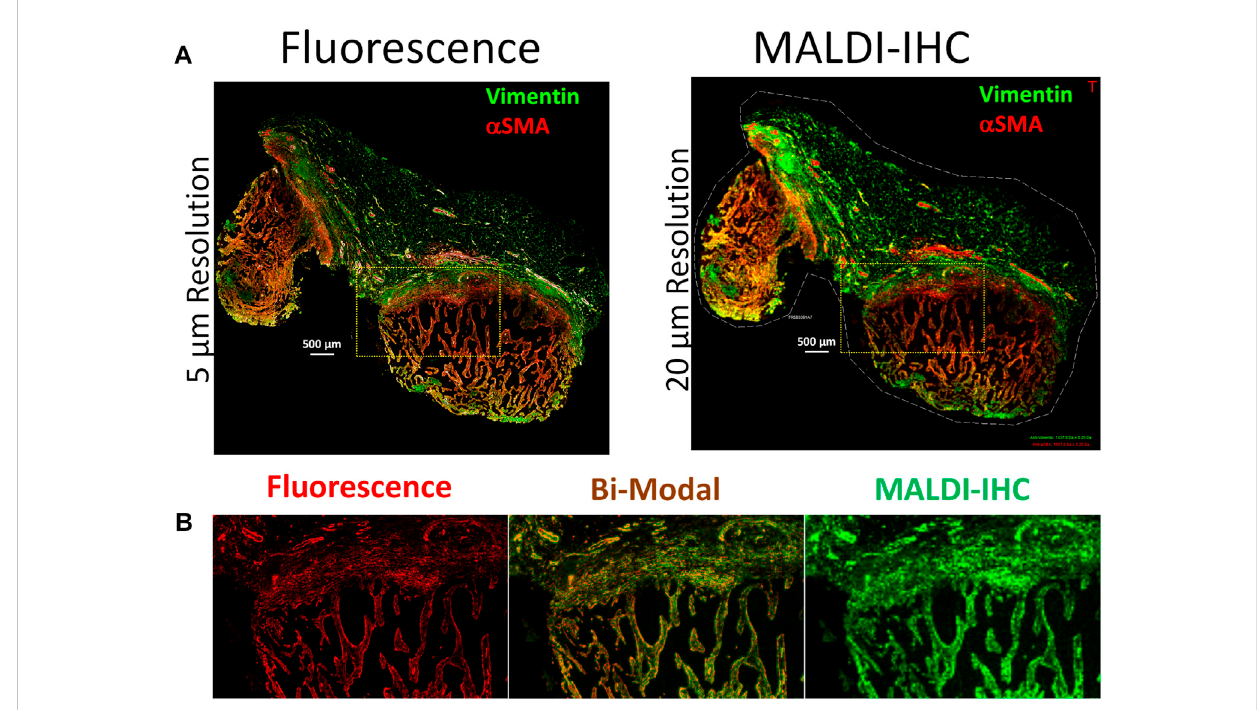
FIGURE 2 Multimodal imaging of an FFPE breast cancer tissue using dual-labeled Miralys ™ probes. (A) Comparison of fl uorescence (left) and MALDI-IHC (right) images for the dual-labeled vimentin and alpha smooth muscle actin ( α SMA) probes. (B) Magni fi ed region shown from the area within the yellow cross-hatched rectangles in A, for both fl uorescence and MALDI-IHC images (left and right, respectively) of the α SMA probe. The center image is a bi- modal interactive merge of both the fl uorescence and